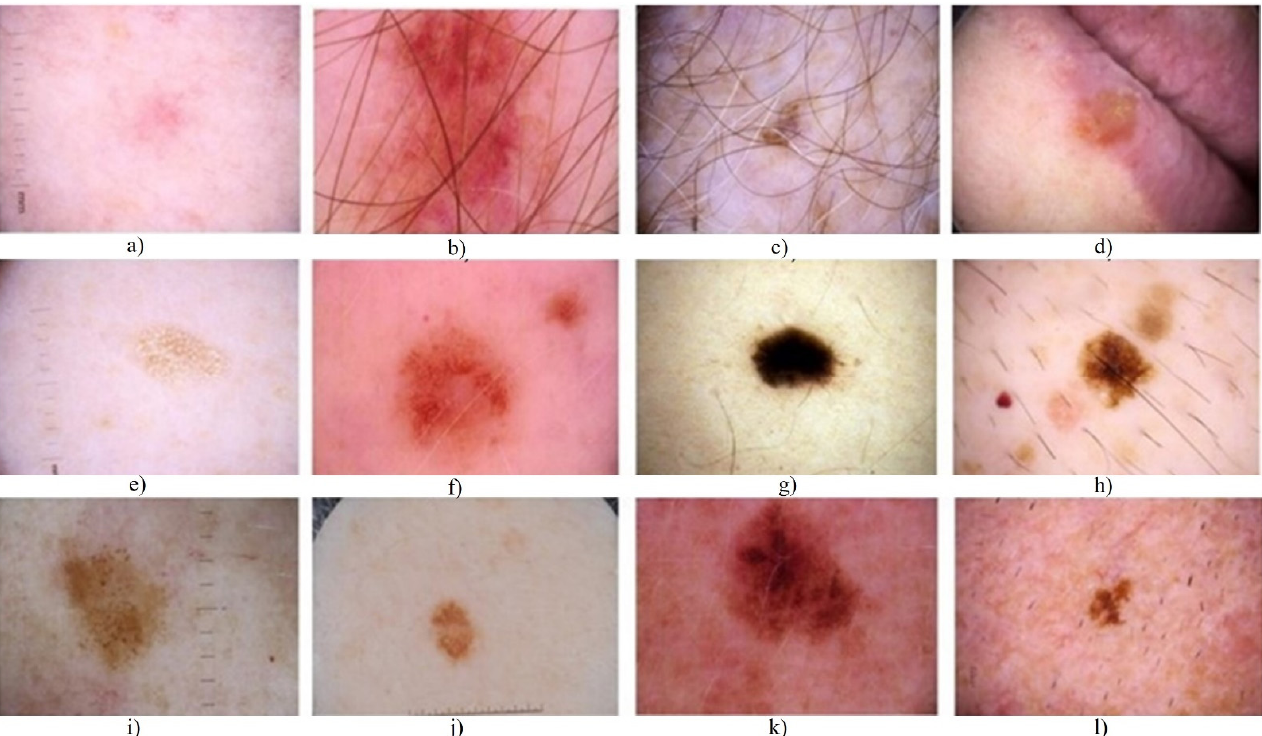
Figure 1. The skin sample lesion images taken from the ISIC 2017 dataset, which have different class differences within due to the various variations, such as severe ( a , d , l ), blurred boundary ( b , d – f , h , l ), inhomogeneity ( b , i , f , h,k ), hair appearance ( g,c ), poor contrast ( h,j ). The difficulties mentioned above are present in the skin lesion datasets. These datasets are used for the automated segmentation process.